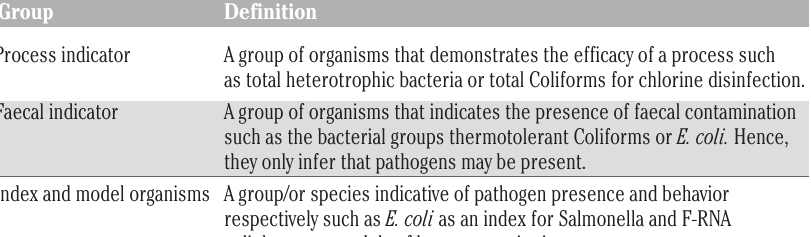
Table 1. Definitions for indicator and index micro-organisms of public health concern.